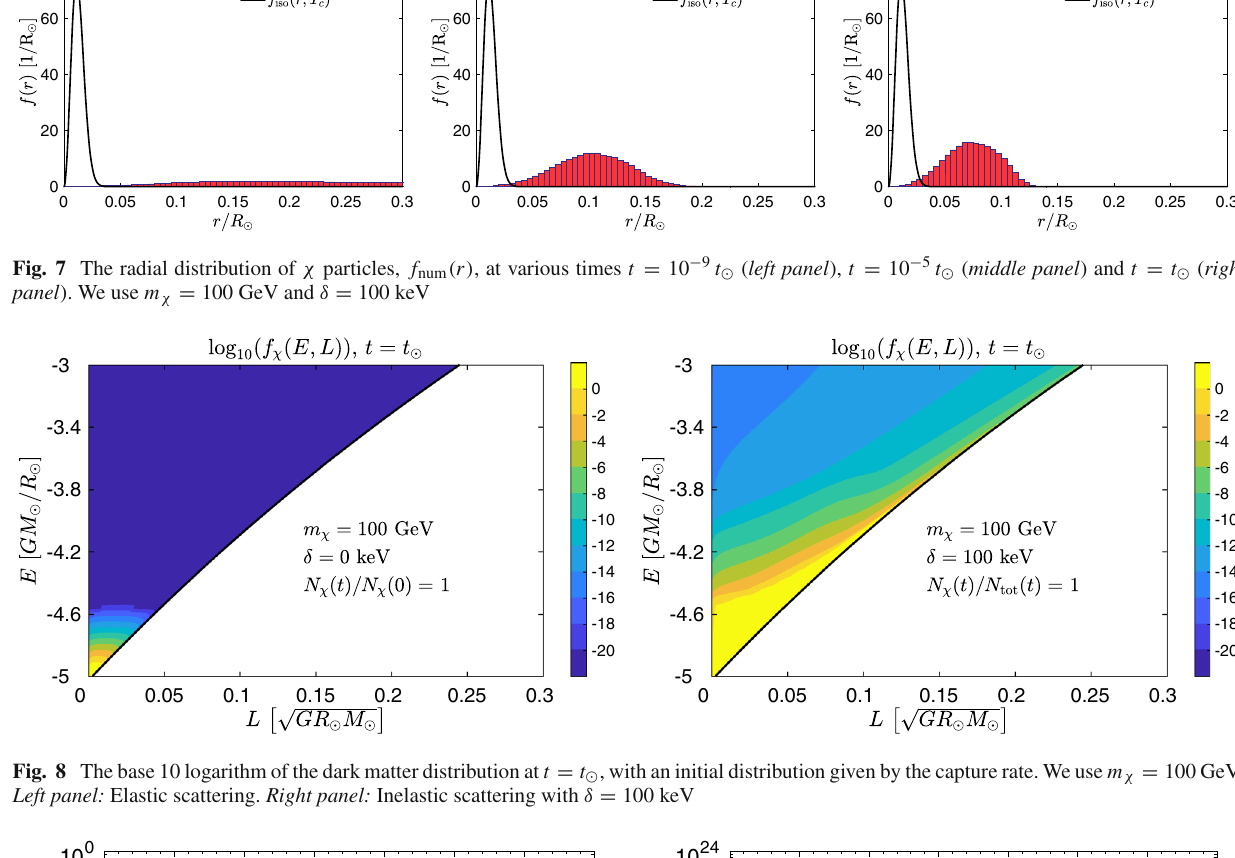
rates (dashed lines) for the numerically computed distributions using = 10 − 42 cm 2 and (cid:13) σ v (cid:14) = 3 × 10 − 26 cm 3 / s. In both panels we σ χ p ann show results for m χ = 20 GeV (black), m χ = 100 GeV (blue) and m χ = 500 GeV